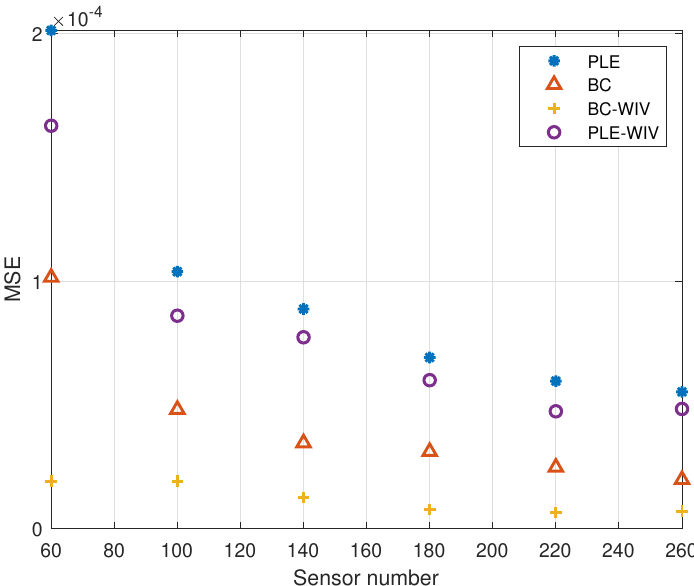
Figure 7. MSE with increasing sensor number at the difference of 40 for each method.